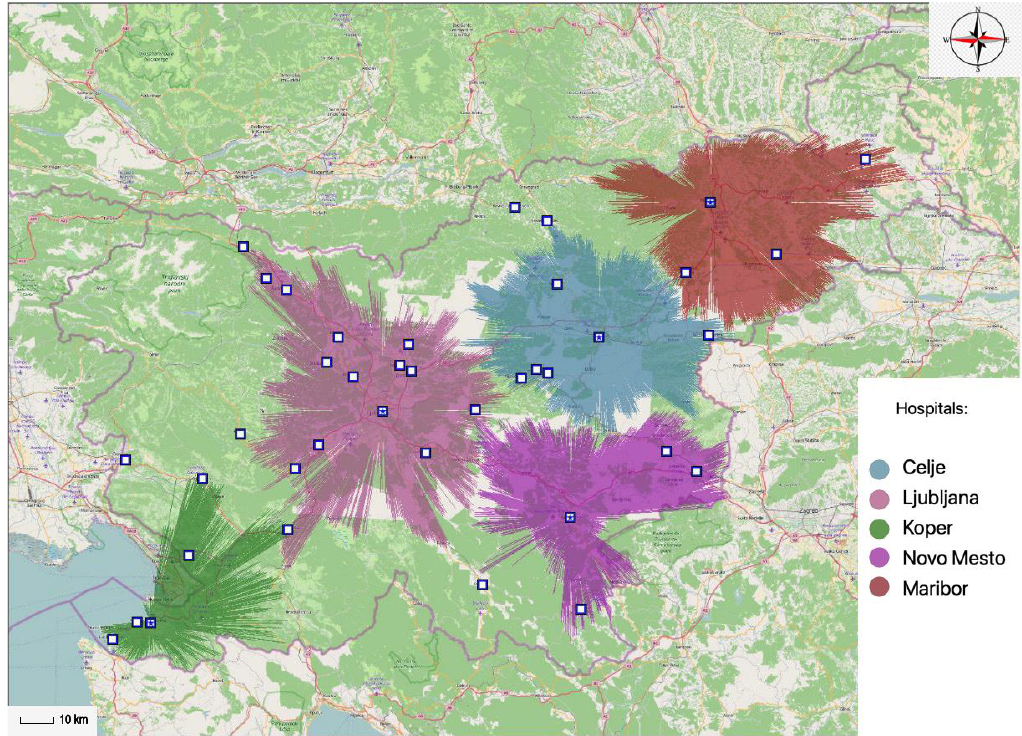
Figure 7. Optimal locations of five different general hospitals within the 45-min time interval.